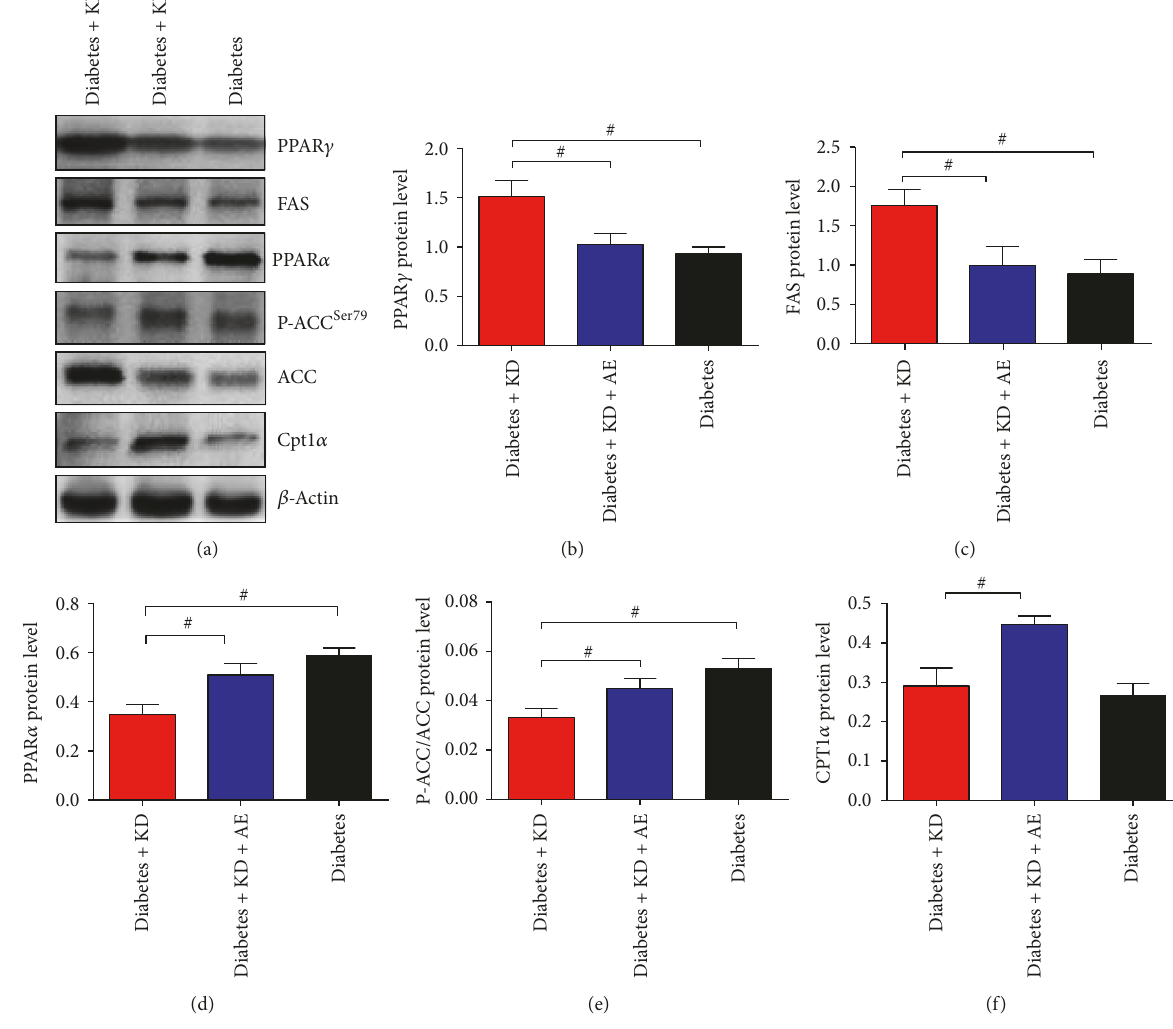
Figure 7: Aerobic exercise activates PPAR 𝛼 and PPAR 𝛾 and target proteins in liver. Diabetic mice were treated with different diet with or without eight-week aerobic exercise (12m/min 5 times/week). Liver tissue lysates were subjected to Western blot analyses with specific antibodies (a). The protein band intensity of (b) PPAR 𝛾 , (c) FAS, (d) PPAR 𝛼 , (e) P-ACC/ACC, and (f) CPT1 𝛼 was normalized to 𝛽 -actin. Data were presented as means ± SEM ( 𝑛 = 6 per group) and statistical analysis was performed with 1-way ANOVA. ∗ 𝑃 < 0.05 versus diabetic group and # 𝑃 < 0.05 versus diabetes + KD